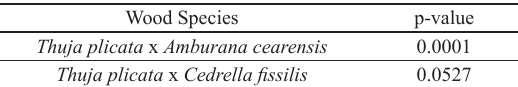
Table 7. Relation between soluble lignin content.